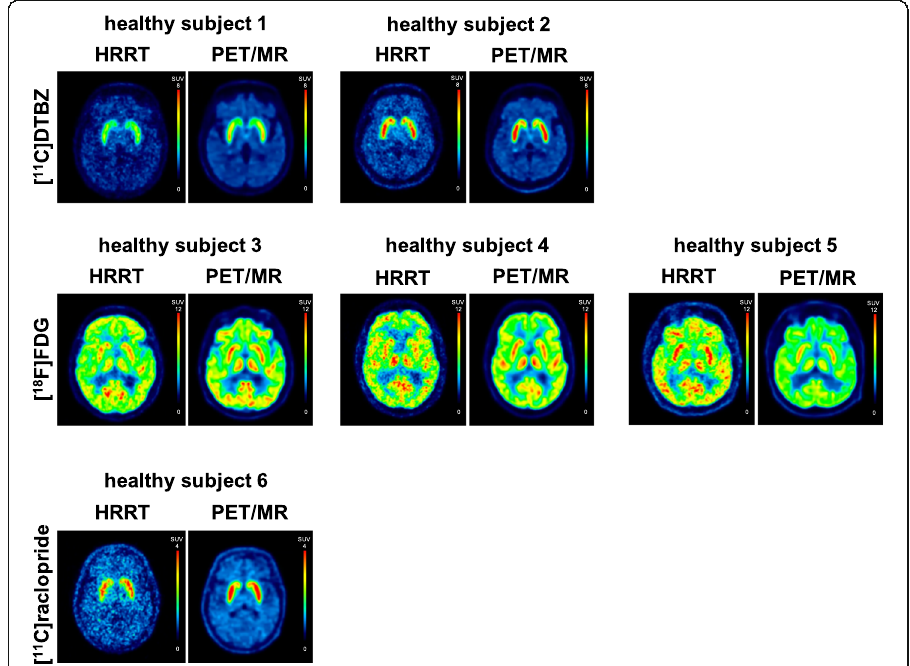
Fig. 6 Representative images of the mean [ 11 C]DTBZ, [ 18 F]FDG, and [ 11 C]raclopride tracer distribution for each subject. Color scales of the images were adjusted based on SUV values for each tracer separately with a common maximum between scanners. PET/MR data were reconstructed with TOF with PSF and filter using 4 iterations and 28 subsets; HRRT data were reconstructed using 6 iterations and 16 subsets and post- processed with a 2.0 mm FHWM Gaussian filter (standard in-house reconstruction). Note: Subject 4 was injected with a lower amount of [ 18 F]FDG activity for the HRRT scan compared to the other scans; hence, noise characteristics differ